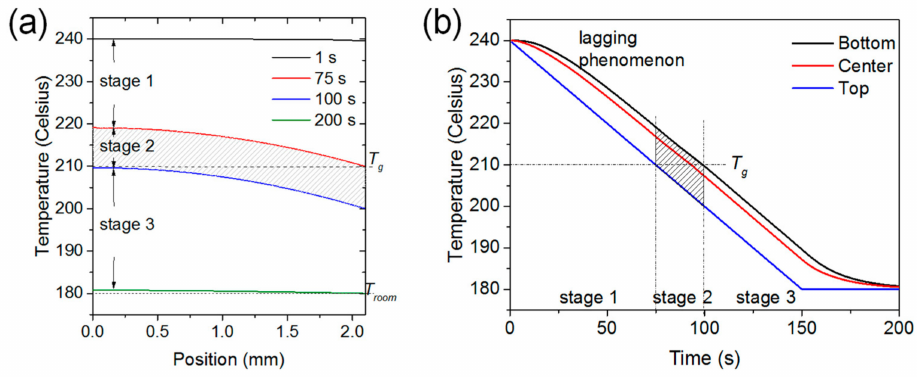
Figure 8. Temperature distribution through plate thickness at different times. ( a ) Temperature-versus- position curves at five different times; and ( b ) temperature-versus-time curves at three different positions.